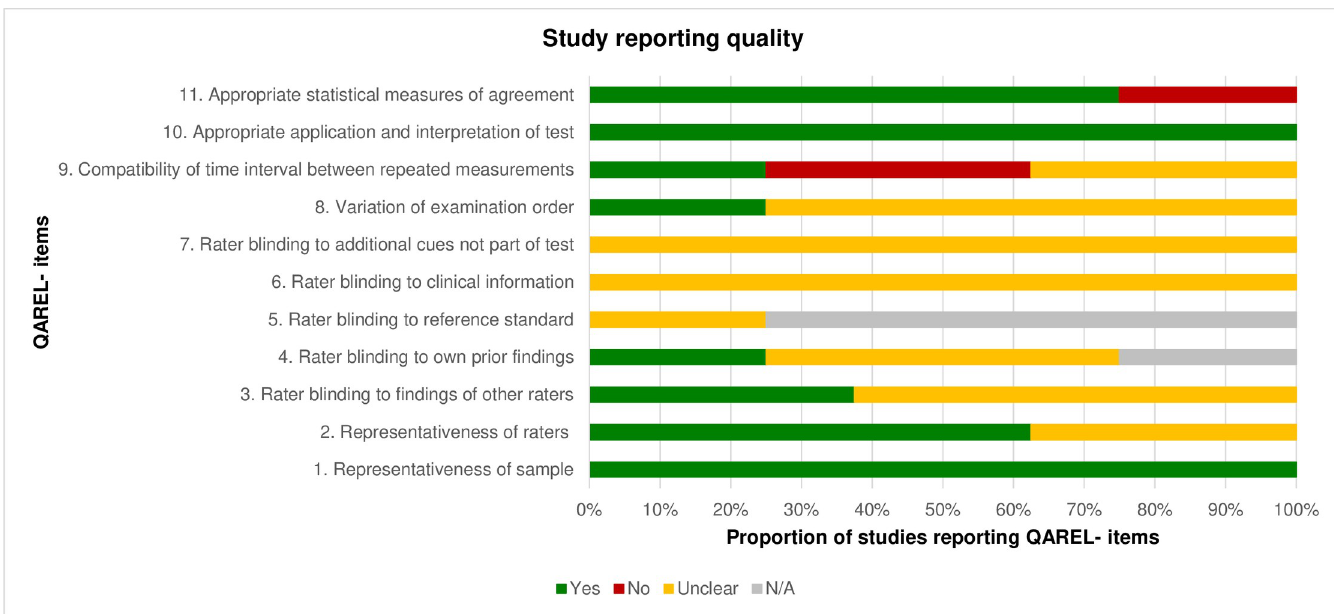
Fig 5. Assessment of study reporting quality of the included reliability studies on imaging diagnostics using the QAREL- checklist. N/A = not applicable.